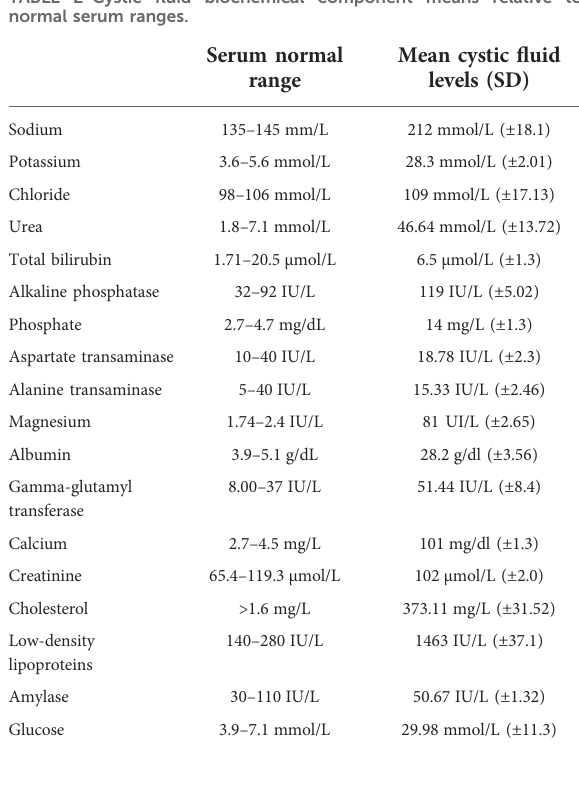
TABLE 2 Cystic fl uid biochemical component means relative to normal serum